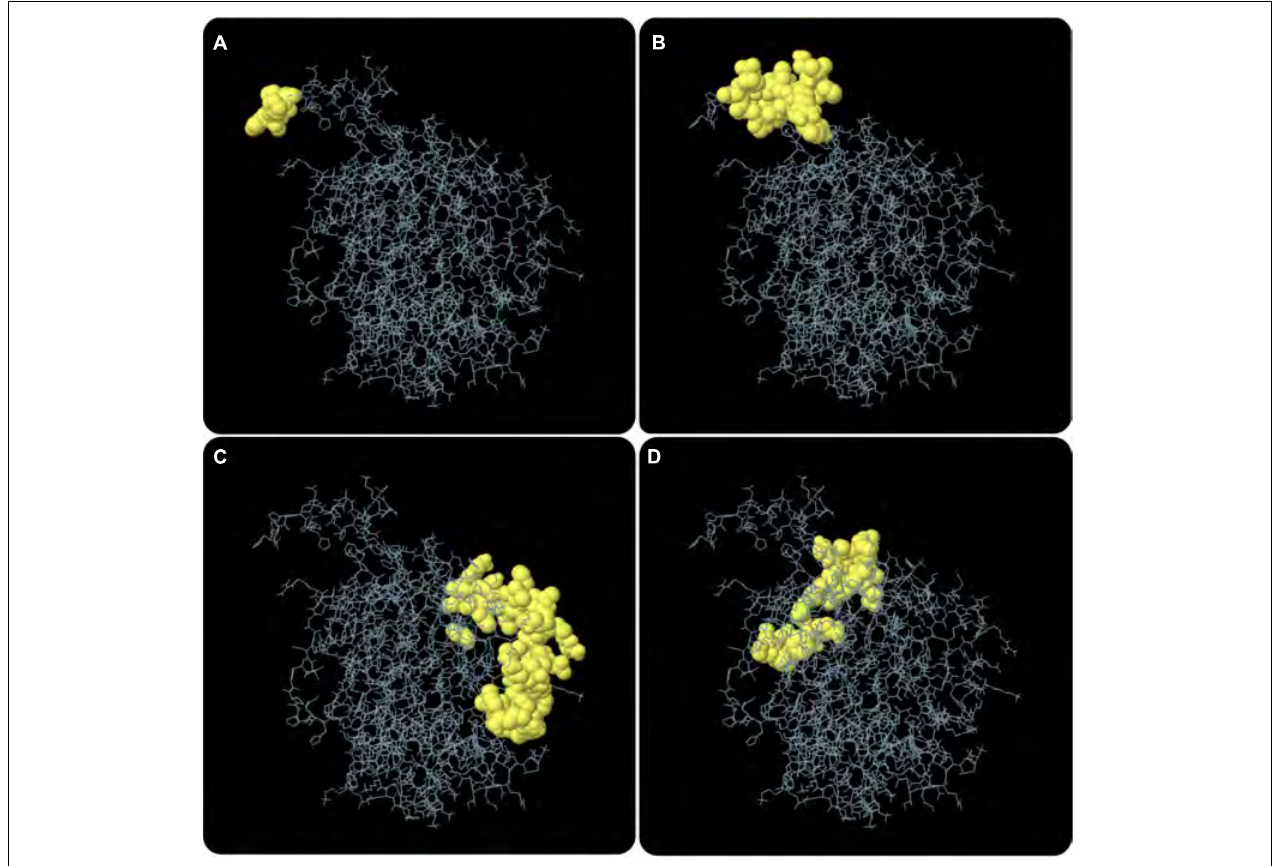
FIGURE 5 | The conformation or discontinuous B cell epitope of the C543P candidate. The yellow balls in panels (A–D) represented 4 conformations or discontinuous B cell epitopes, respectively, and the rest were shown in gray. TABLE 4 | The conformational B cell epitopes residues of the C543P candidate predicted by the ElliPro. No Residues Number of residues